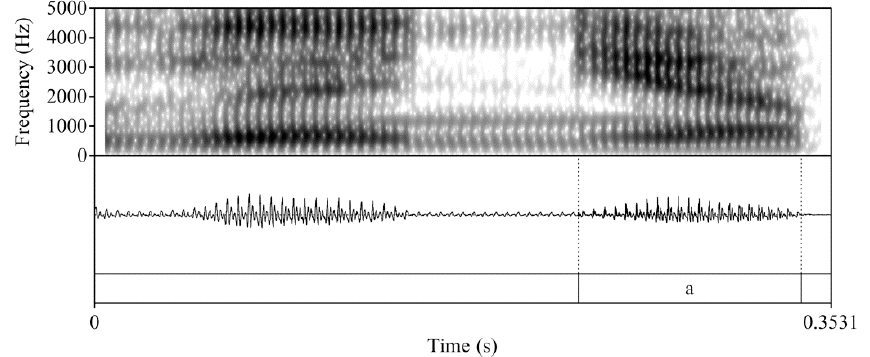
/ de ñ a / ‘deña’ in Spanish